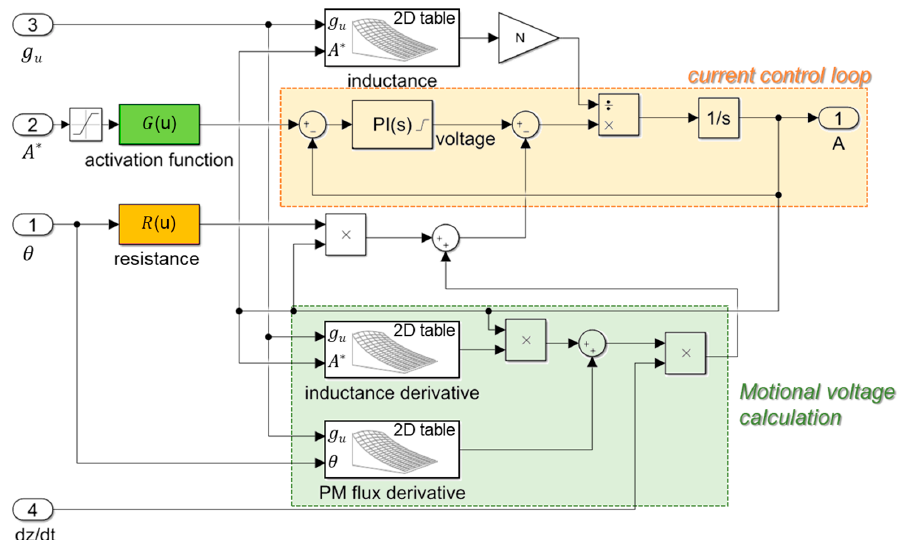
Figure 13. Control scheme of the AHMB electrical system.